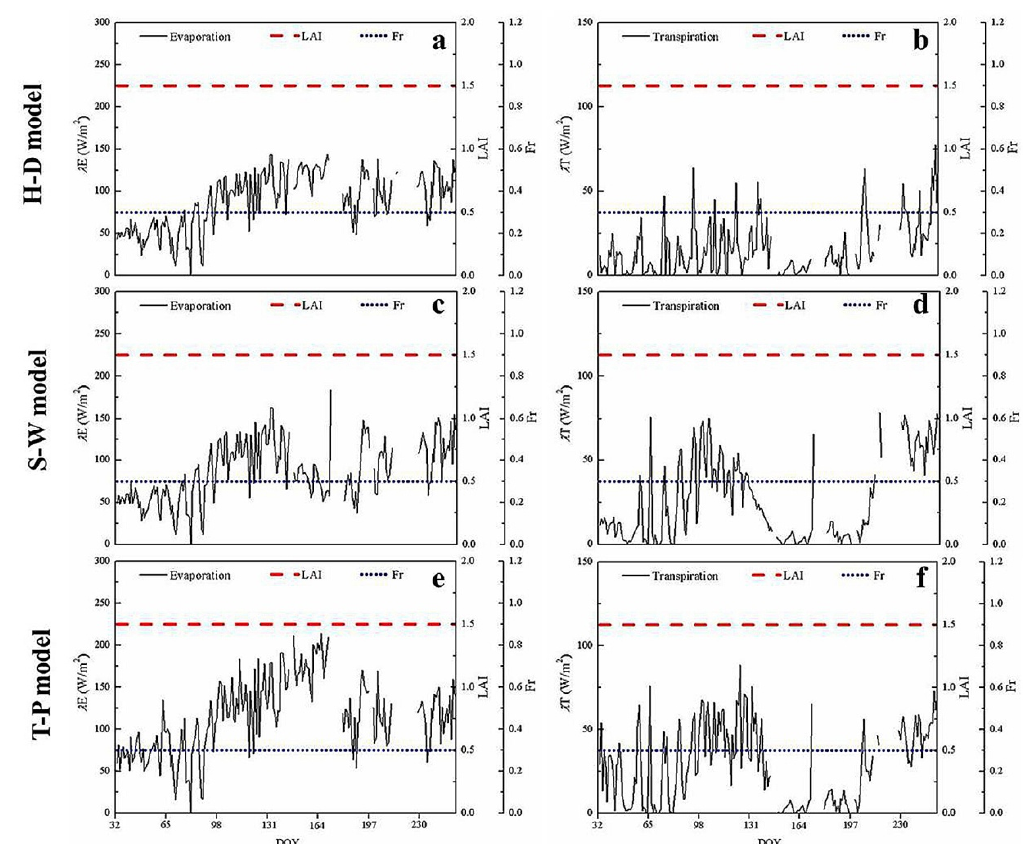
Figure 6. Variations in daily leaf area index (LAI), fractional vegetation coverage ( F r), and estimated evaporation ( λ E) ( left ) and transpiration ( λ T) ( right ) from three dual-source